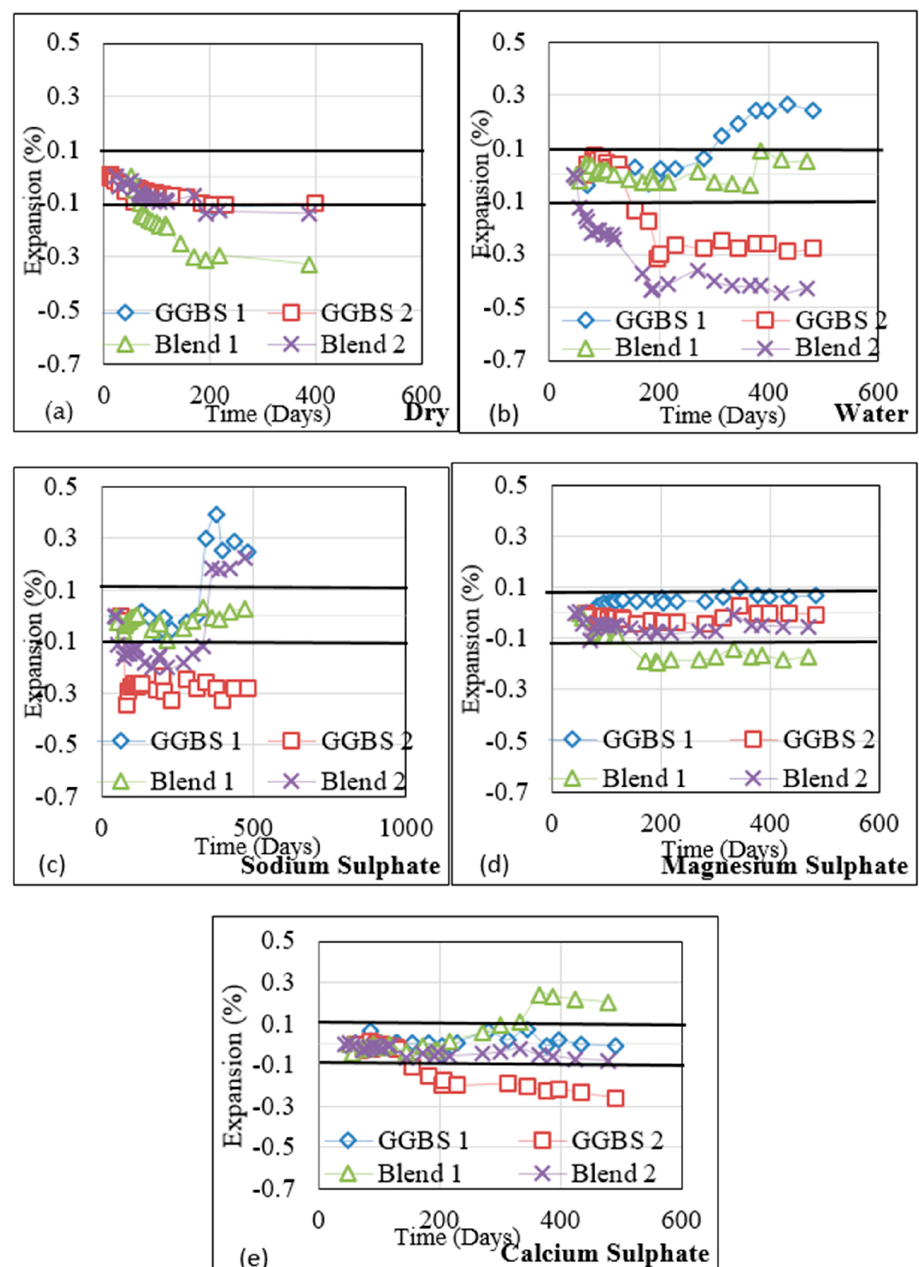
Figure 5. Expansion/shrinkage of Group 1 AASC and AAS/F concrete mixes (cured 28 days before exposure) during ( a ) dry condition and immersion in different solutions [( b ) Water, ( c ) Na 2 SO 4 , ( d ) MgSO 4 , ( e ) CaSO 4 ]; ± 0.1% tolerance accepted by ASTM C1012 is shown on the figures as full horizontal black lines.